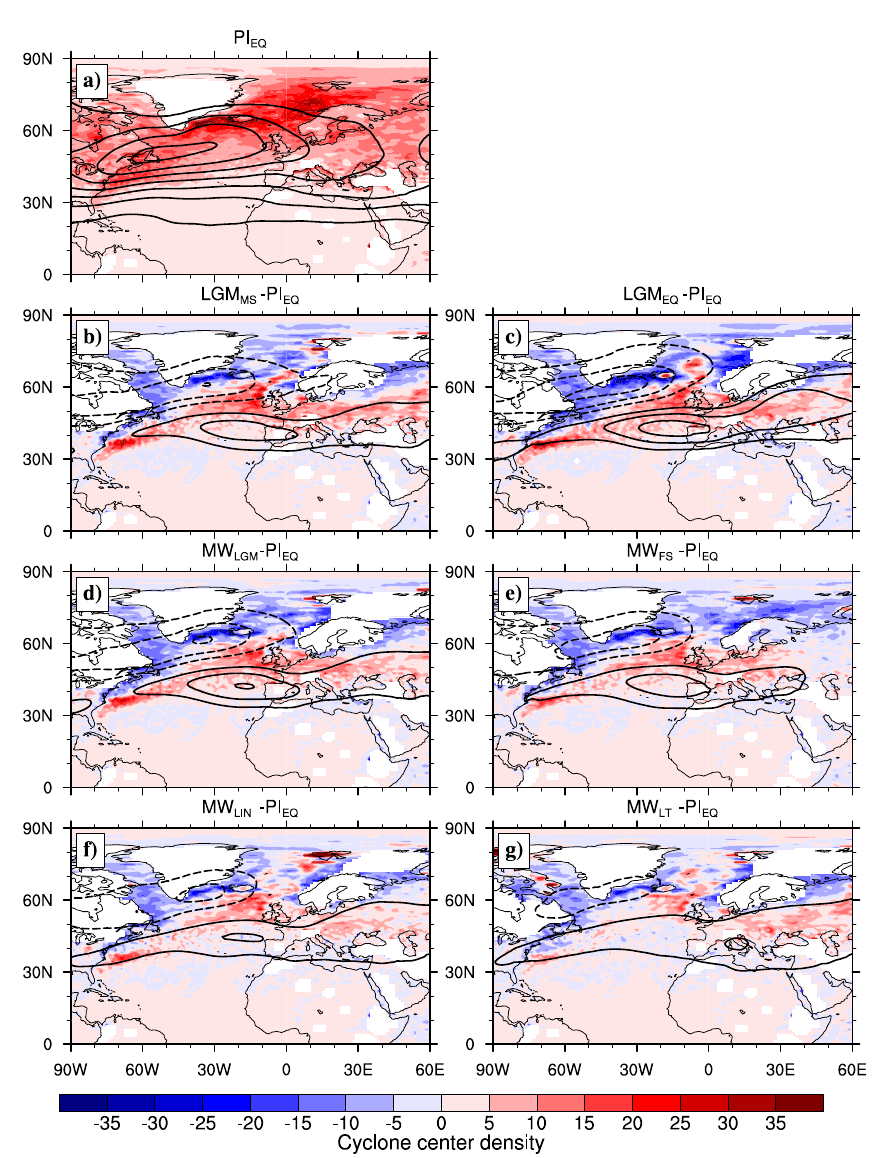
Fig. 7. Synoptic activity in winter (DJF) using two different measures, namely cyclone center density (colours, only values where the altitude is below 1000m) and band-pass filtered (2.5 to 6 days) standard deviation of the 500hPa geopotential height (contours). The mean value for PI EQ are shown in (a) while in (b–g) the anomalies of the different glacial simulations with respect to PI EQ are presented. The contour interval is every 10gpm, negative contours are dashed and the zero contour line is